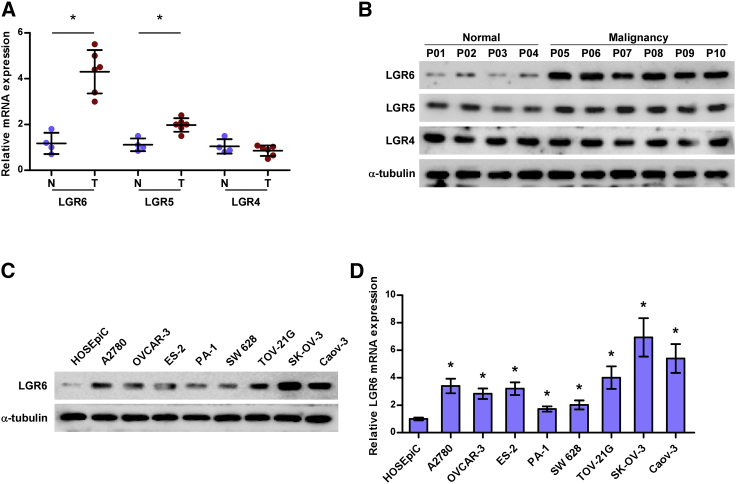
LGR6 Is Upregulated in Ovarian Cancer(A) LGR4–6 expression in six ovarian cancer tissues and four normal ovarian epithelial tissues by real-time PCR. Each bar represents the median values ± quartile values. *p < 0.05. (B) LGR4–6 expression in six ovarian cancer tissues and four normal ovarian epithelial tissues by western blotting. (C and D) Western blotting (C) and real-time PCR (D) of LGR6 expression in one normal ovarian epithelial cell HOSEpiC and eight ovarian cancer cell lines. GAPDH was used as an endogenous control in RT-PCR, and α-tubulin was detected as a loading control in the western blot. Error bars represent the mean ± SD of three independent experiments. *p < 0.05.